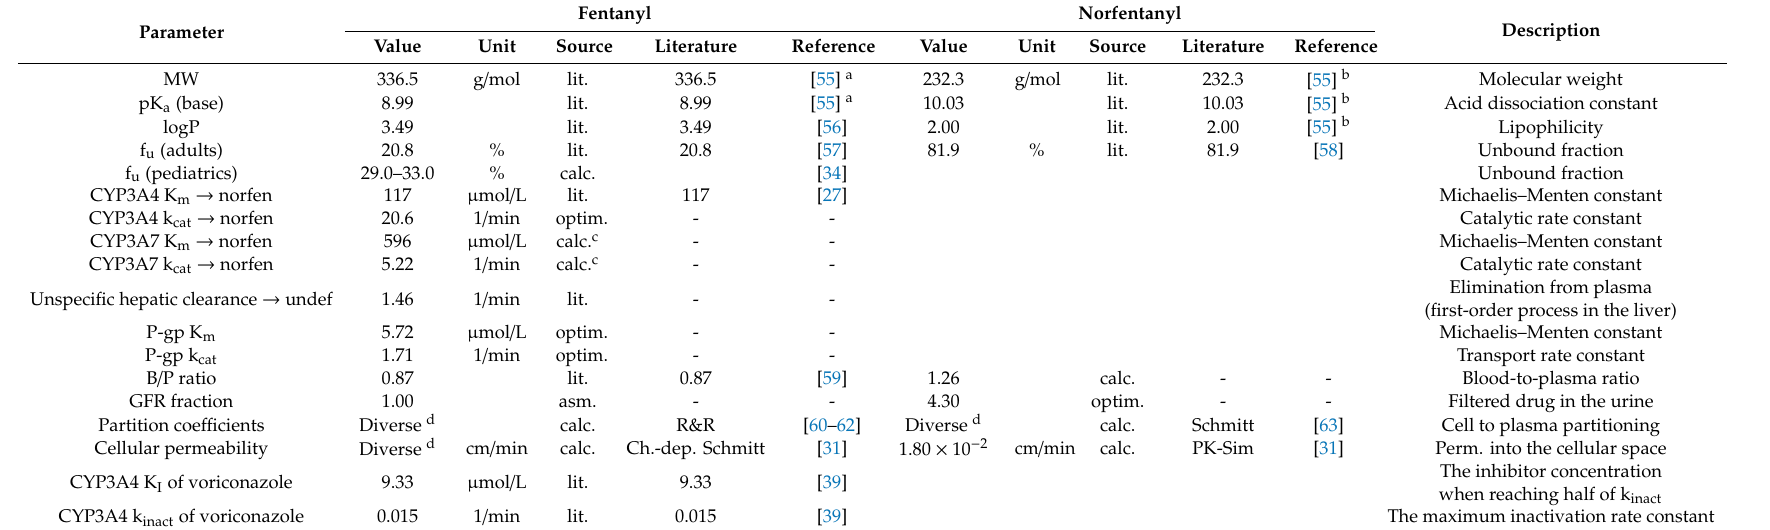
Table 3. Fentanyl and norfentanyl drug-dependent model